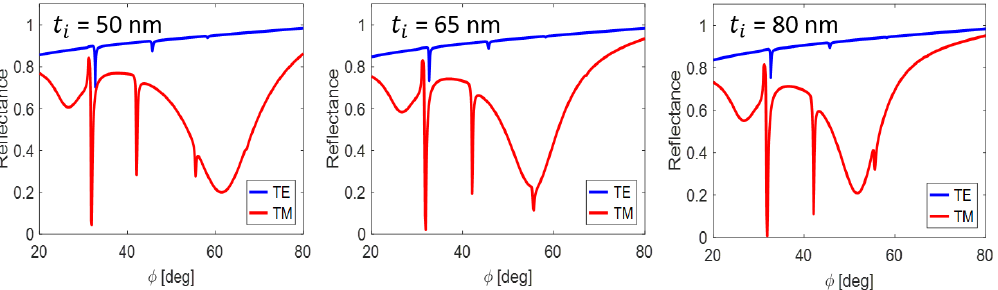
Figure 7. Mutual coupling of the TM 1 waveguide mode and the short-range plasmonic mode for the layer thicknesses of the structure 10/ t i /34/80/450/100 (see previous figure for explanation).